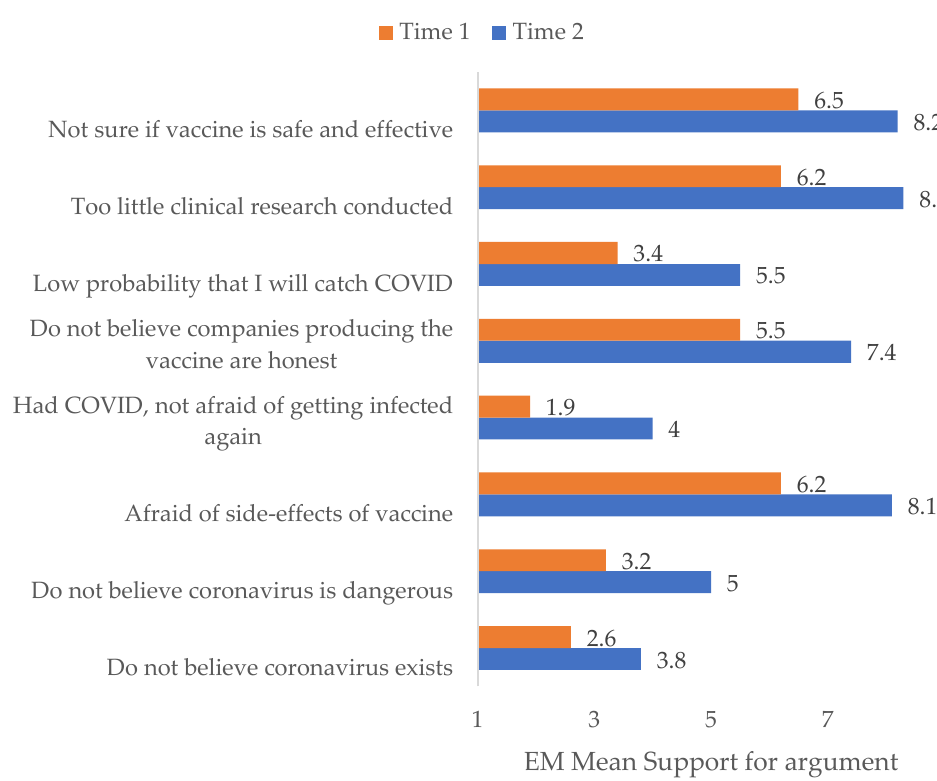
Figure 1. Reasons to not get vaccinated against COVID-19 between Time 1 and Time 2. Conversely, it turned out that support for all the reasons to get vaccinated was significantly lower at Time 2 than at Time 1 in the pro-vaccine sample (F(1388) = 573.765, p < 0.001, η 2 p = 0.597); all pairwise comparisons p < 0.001 (Bonferroni corrected). Results are presented in Table 3 and Figure 2. Table 3. Changes in reasons to vaccinate between Time 1 and Time 2 n consistently pro-vaccine individuals.